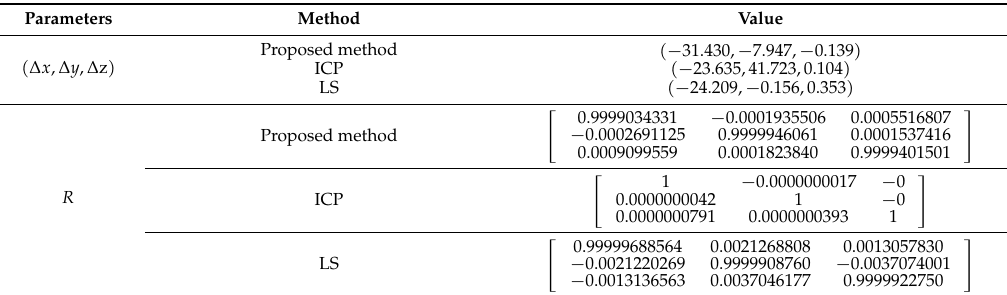
Table 2. Comparison of transformation parameters for the second case.